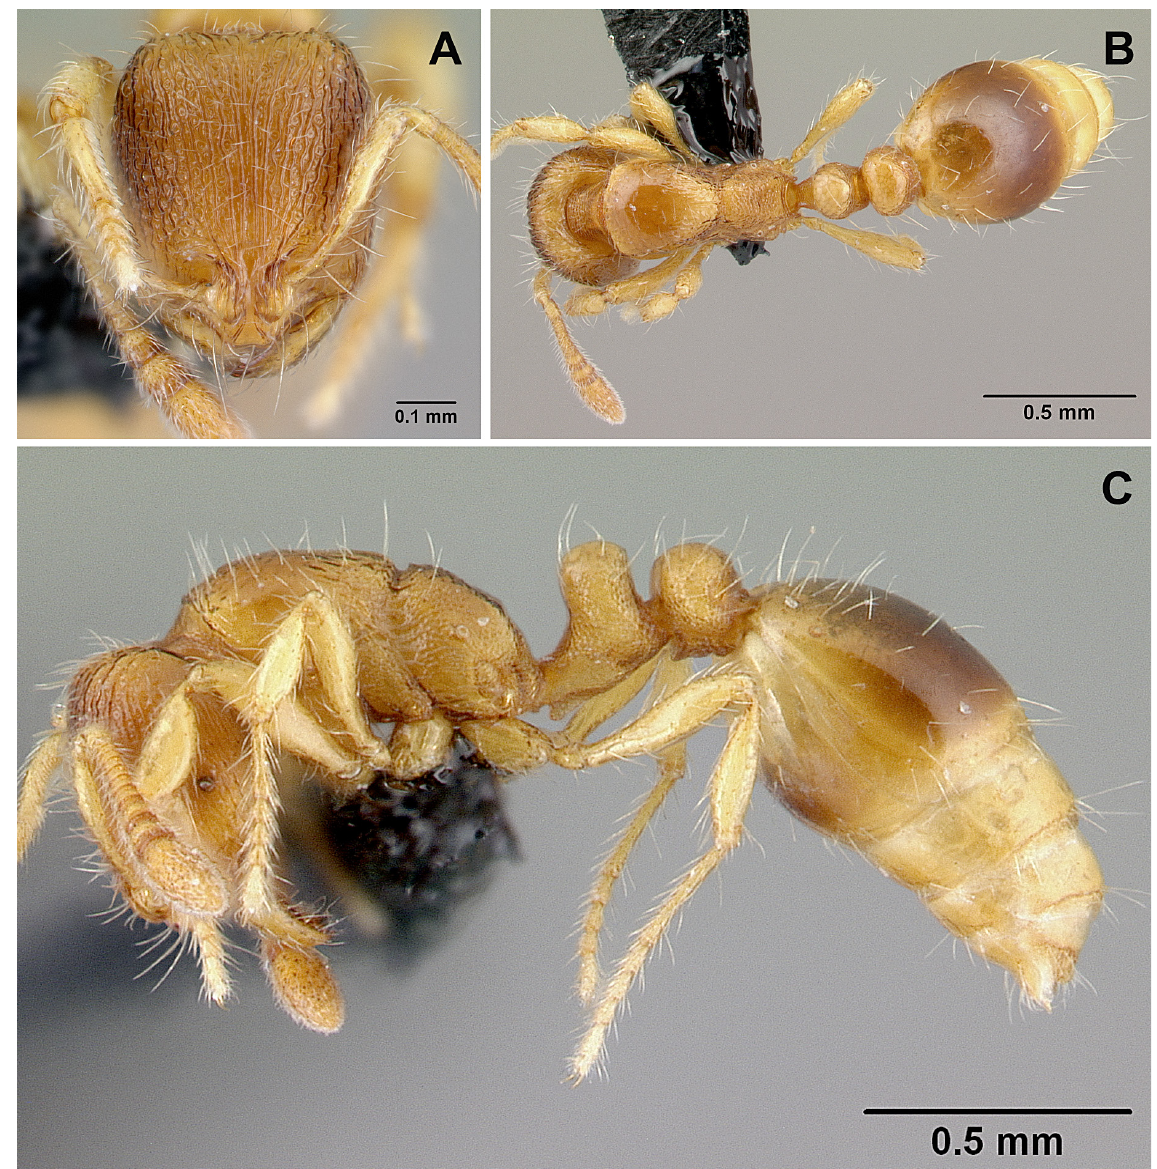
Fig. 3. Kempfidris inusualis (Fernández, 2007) comb. nov., worker from Maroa, Amazonas, Venezuela, specimen CASENT0217050. High-resolution images from AntWeb. A . Head in full face view. B . Body in dorsal view. C . Body in lateral view. Images by Erin